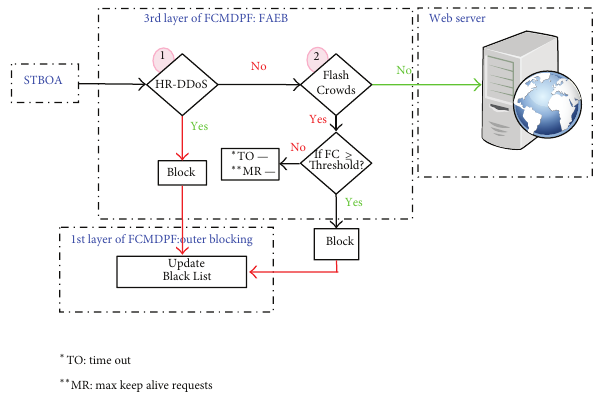
Figure 4: FAEB scheme verifies the incoming requests.